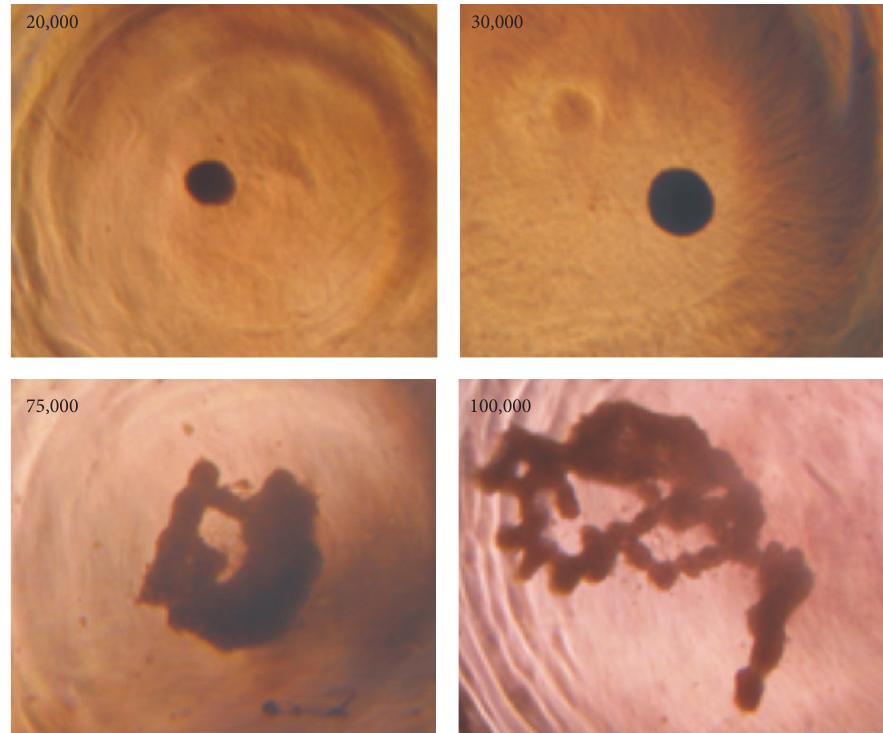
Figure 2: Spheroids obtained from primary human bone cells in three-dimensional culture, at day 7, developed with different cell densities (20x objective).